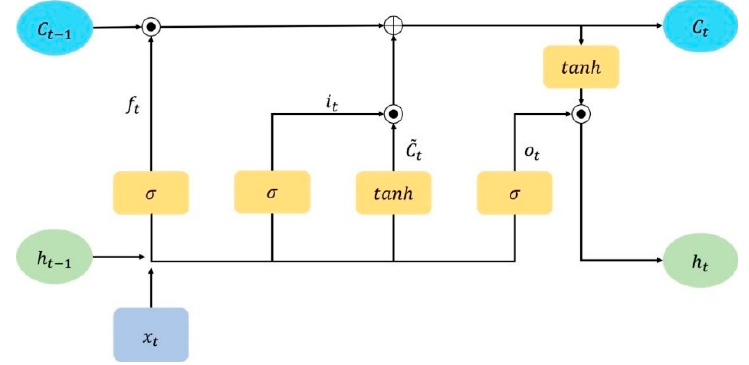
Figure 9. LSTM architecture.